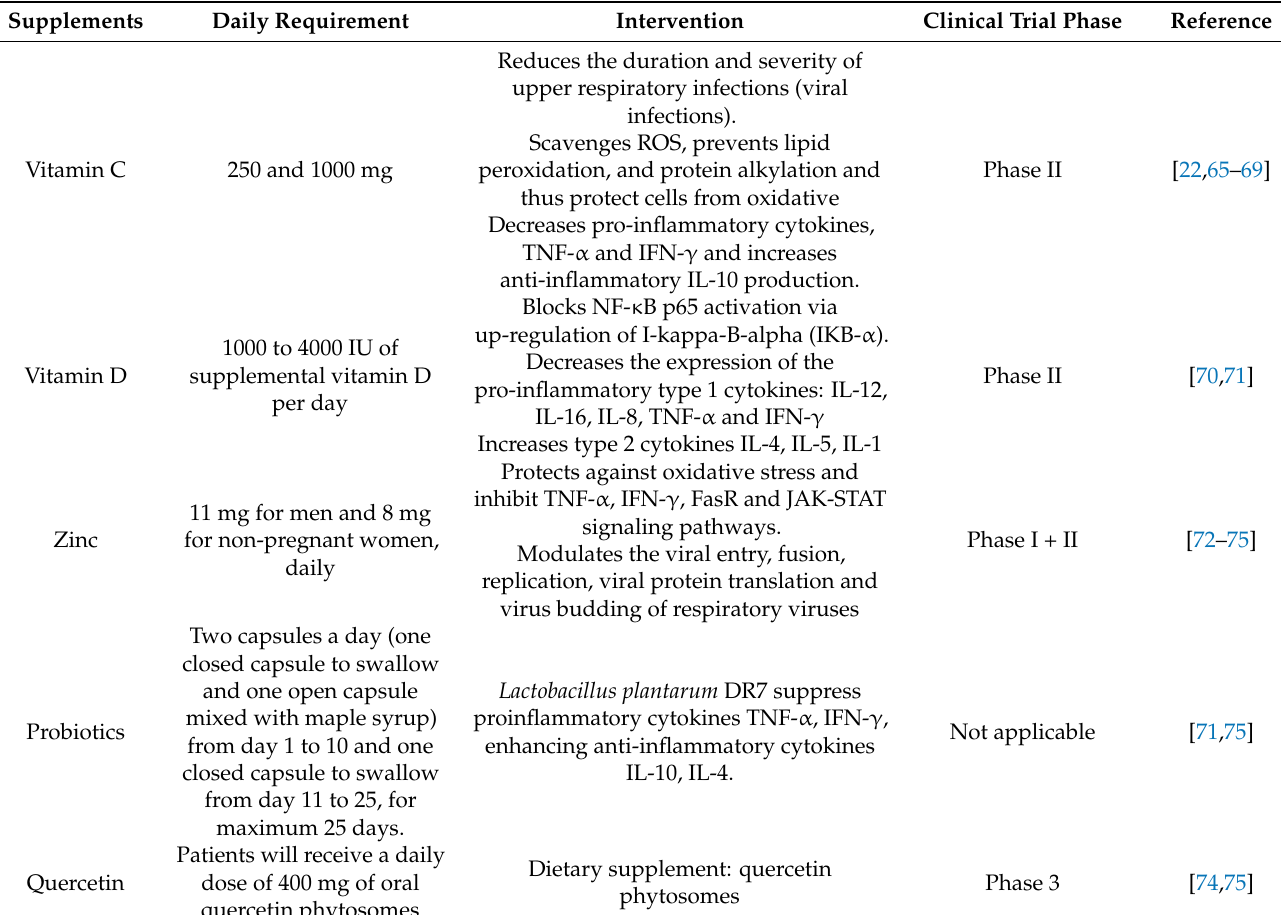
Table 1. Supplements their role in COVID 19 treatment with daily requirement and clinical trial